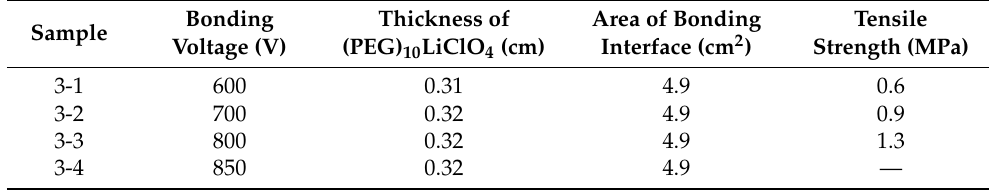
Figure 10. The SEM image of bonding interface of (PEG) 10 LiClO 4 and Al: ( a ) bonding at 600 V, ( b ) bonding at 700 V, ( c ) bonding at 800 V.